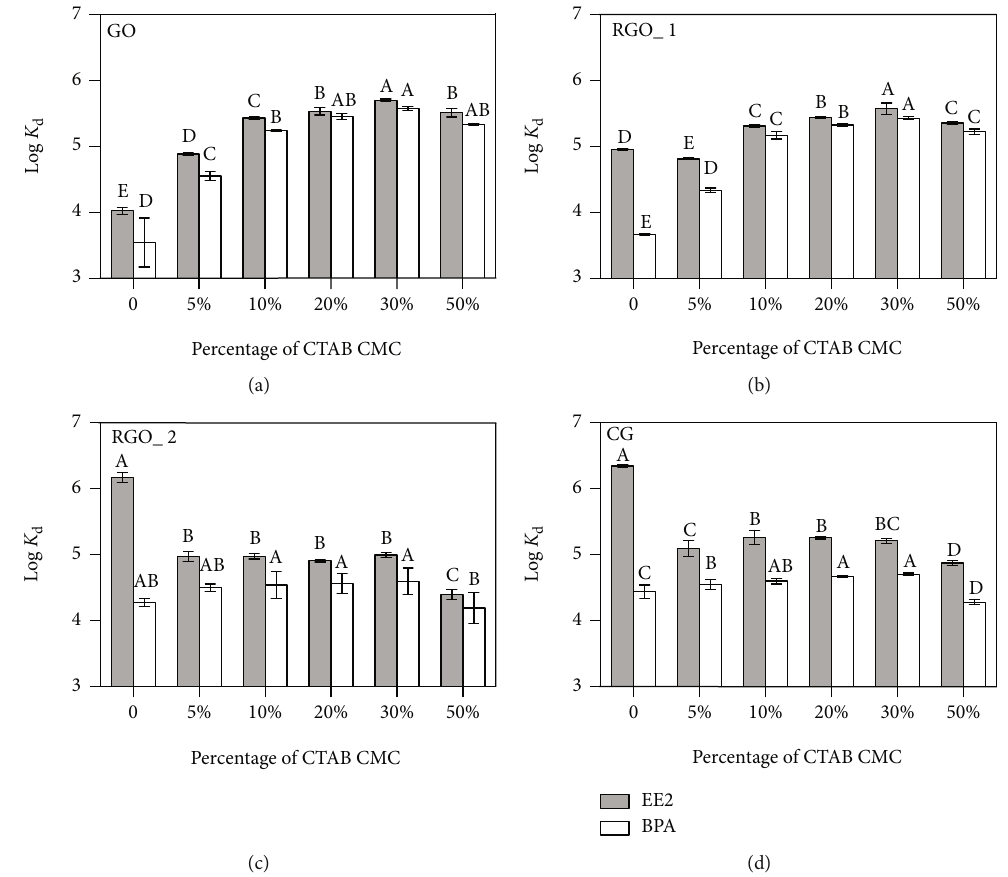
Figure 5: Adsorption coe ffi cients of EE2 and BPA to GMs under di ff erent concentrations of CTAB. Di ff erent letters marked on the top of the bars indicate signi fi cant di ff erences in each group ( p < 0 : 05 ).